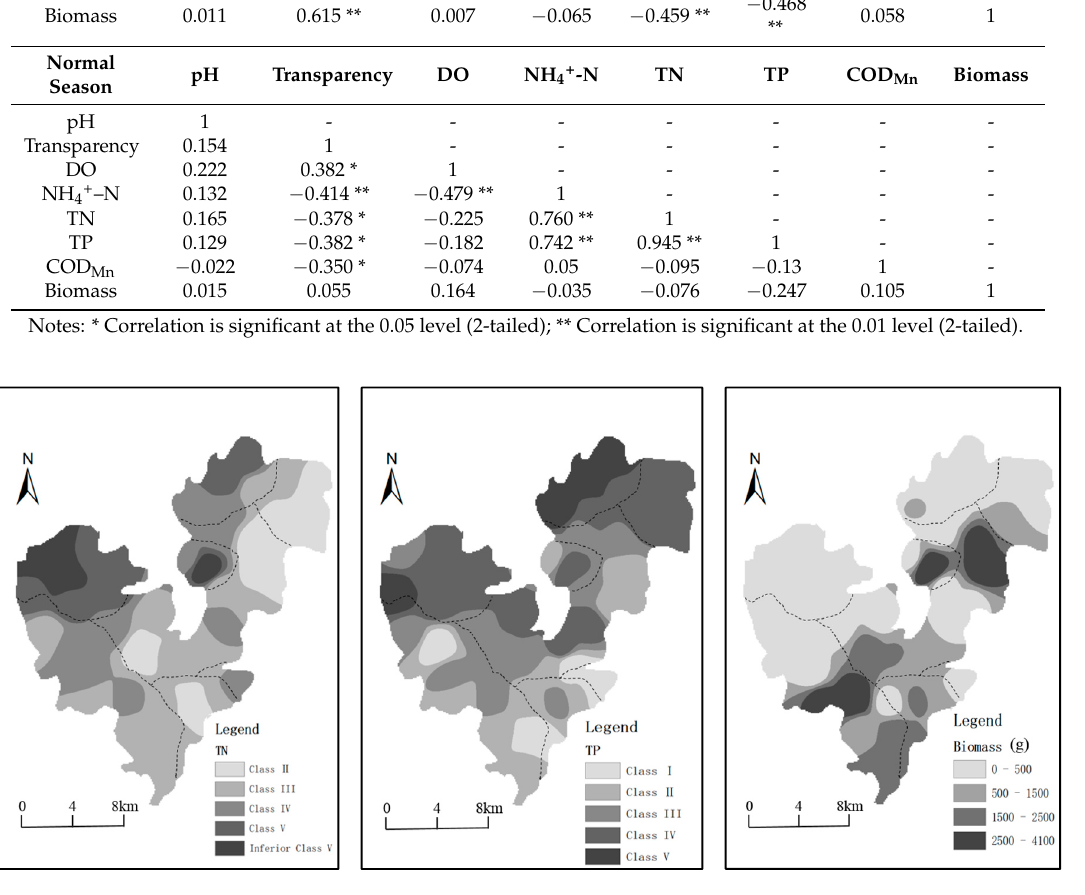
( c ) Figure 7. Spatial variability in TN, TP and biomass in the dry season: ( a ) TN; ( b ) TP; and ( c ) Biomass. Further investigations were conduct to explore the effects of water quality variables on the growth of different submerged aquatic plants by stepwise multiple linear regression (MLR) method. Results suggested significant interactions between biomass of different submerged aquatic plants and water quality parameters during dry and wet seasons (Table 4). In dry season, biomass of submerged aquatic plants was significantly influenced by the concentrations of NH 4+ –N. The growth of Myriophyllum verticillatum and Ceratophyllum demersum L. was mainly affected by NH 4+ –N concentration, and Stuckenia pectinata (L.) Börner sago pondweed was significantly influenced by pH. In wet season, the biomass of Myriophyllum verticillatum , and Ceratophyllum demersum L. was closely associated with TN concentration, and Stuckenia pectinata (L.) Börner sago pondweed was closely related to the water transparency. In addition, the correlation between water quality parameters and biomass of Potamogeton malaianus , Potamogeton maackianus , Vallisneria natans and Hydrilla verticillata are not observed in the three seasons. Overall, it might be concluded that the concentrations of NH 4+ –N and